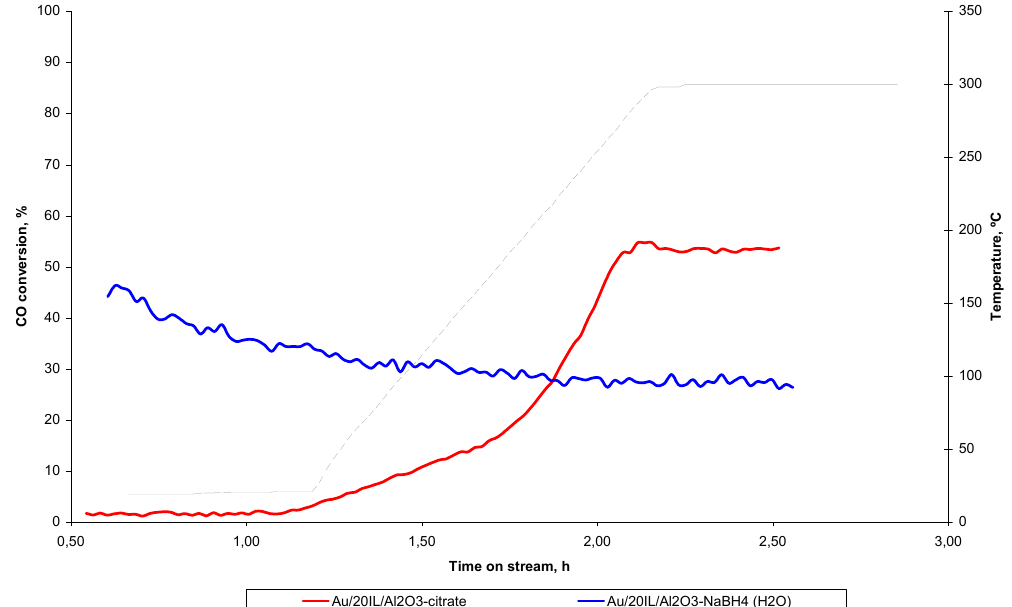
Figure 7. Total CO conversion as a function of time on